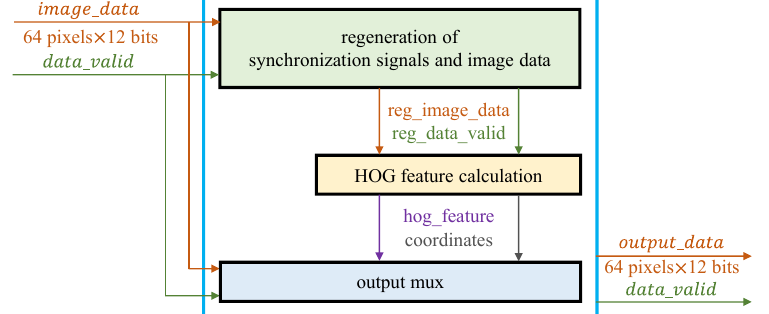
Figure 6. Image processing architecture for the proposed object detection algorithm.